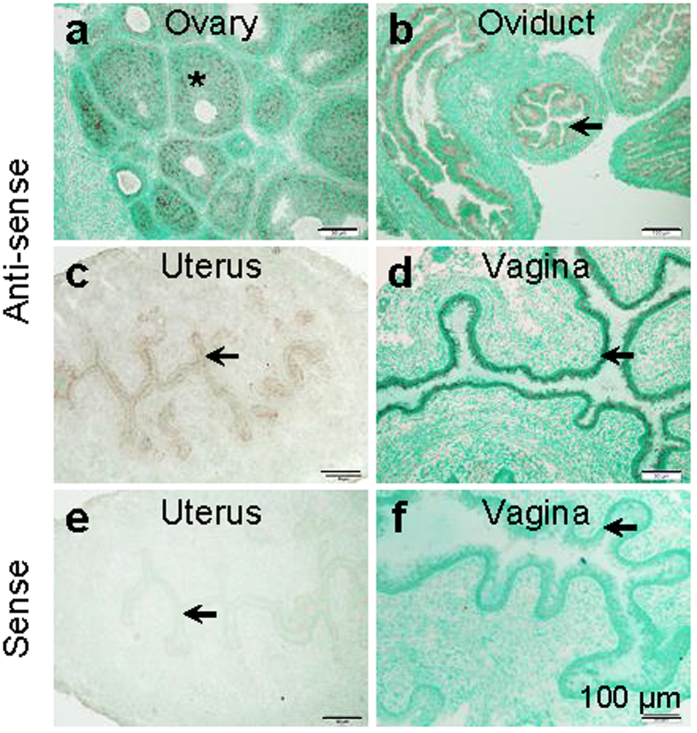
Localization of Lhfpl2 mRNA in 4 weeks old female reproductive tract by in situ hybridization.(a–d) Detection of Lhfpl2 mRNA using an Lhfpl2 anti-sense probe in ovary (a), oviduct (b), uterus (c) and vagina (d). (e,f ) Negative control using an Lhfpl2 sense probe in uterus (e) and vagina (f ). *Follicle; black arrow, epithelium; scale bar, 100 μm.